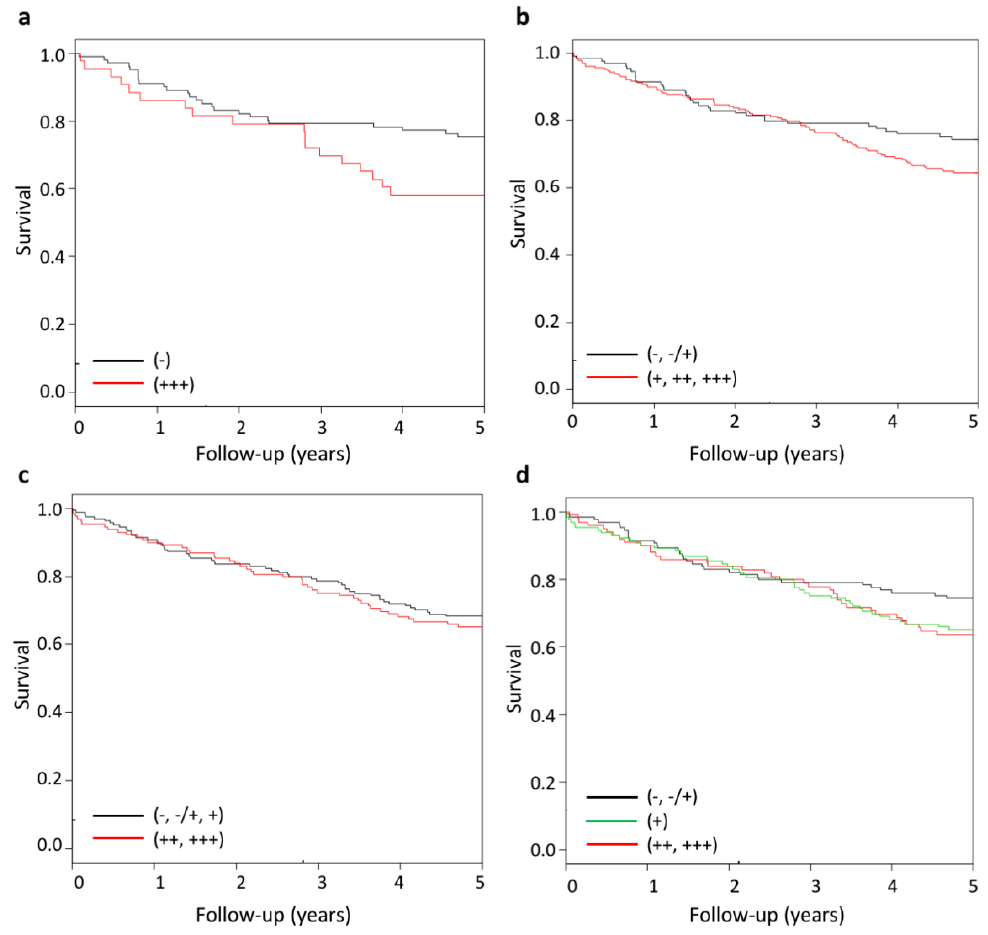
Figure 3. Kaplan–Meier curves at 5 years showing an increased risk of mortality rate in CRC patients with very high Wnt-11 levels. Patients were stratified for Wnt-11 levels as follows: ( a ) negative ( − ) and very high ( +++ ), p = 0.04, ( b ) negative or low ( − , ± ) and moderate, high or very high ( + , ++ , +++ ), p = 0.08, ( c ) negative or low or moderate ( − , ± , + ) and high or very high ( ++ , +++ ), p = 0.21, and ( d ) negative or low ( − , ± ), moderate ( + ) and high or very high ( ++ , +++ ); p = 0.11 ( + ) and 0.13 ( ++ , +++ ); Cox regression analysis, see Tables S5–S7 for HR, CI and unadjusted and adjusted analyses, and Figure S6 and Table S4 for 3-year mortality.